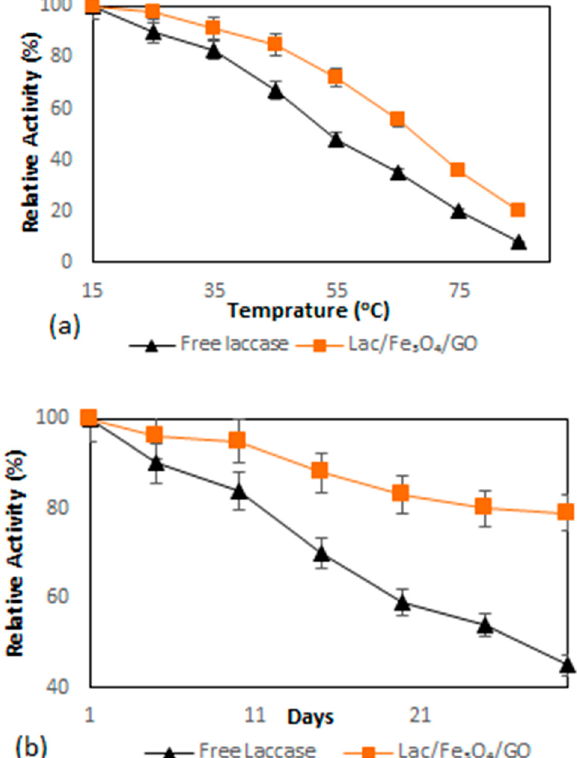
Figure 4. ( a ) Thermal stability of free laccase and Lac/Fe 3 O 4 /GO determined at different temperatures (15–85 °C) in PBS solution (0.1 M, pH = 5) by the ABTS aerobic oxidation reaction for two hours. ( b ) Storage stability of free laccase and Lac/Fe 3 O 4 /GO in PBS solution (0.1 M, pH = 5) determined by the ABTS aerobic oxidation reaction at 4 °C. Experiments were performed in triplicate. The error bars were determined (5%).